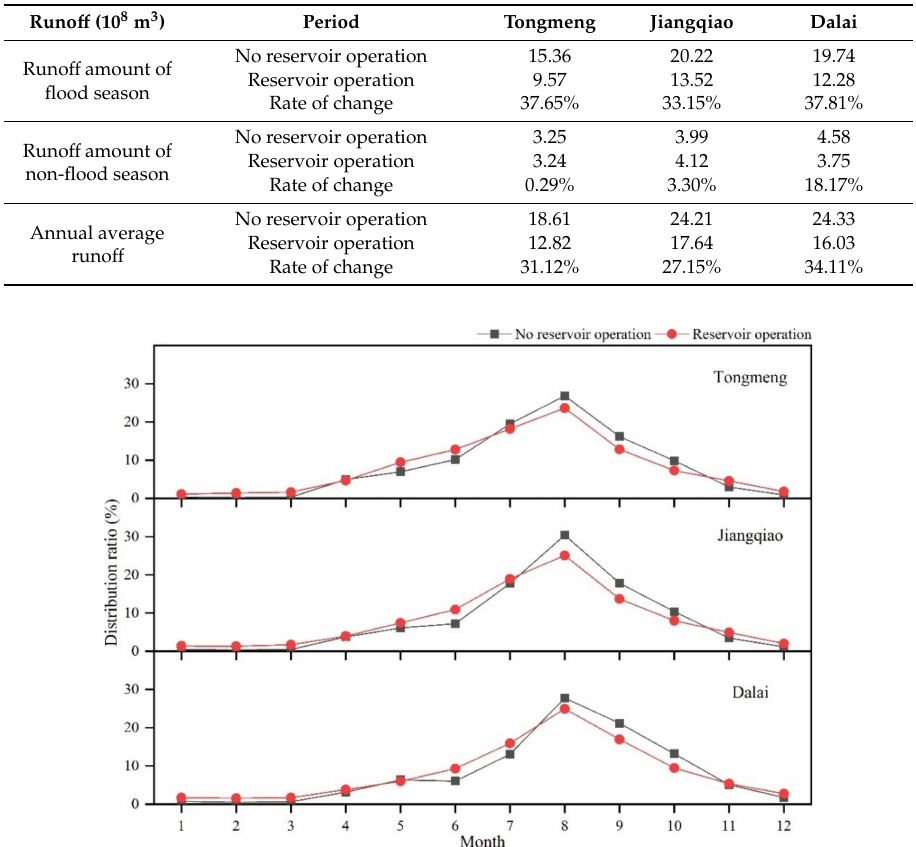
Figure 3. Distribution ratio of mean monthly runo ff before and after the reservoir